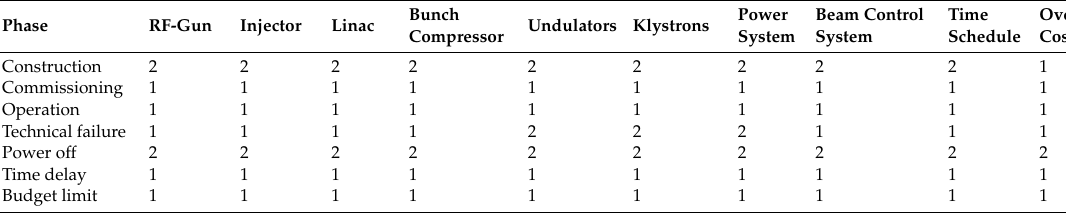
Table 2. A draft Risk Analysis